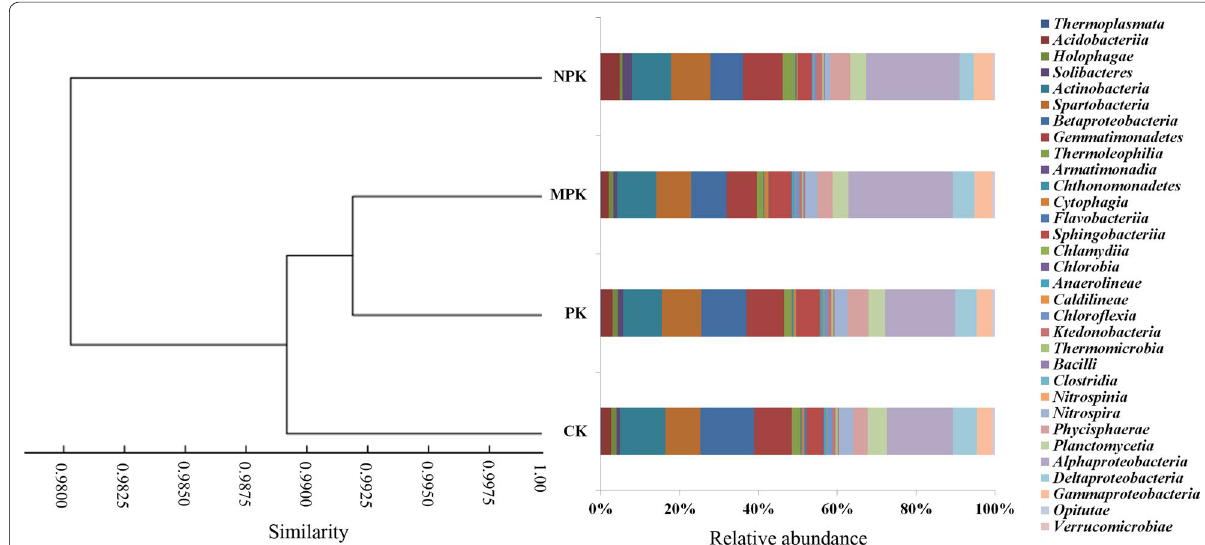
Fig. 2 Cluster analysis of the 16S rDNA composition of soil-dwelling microbial communities at the class level